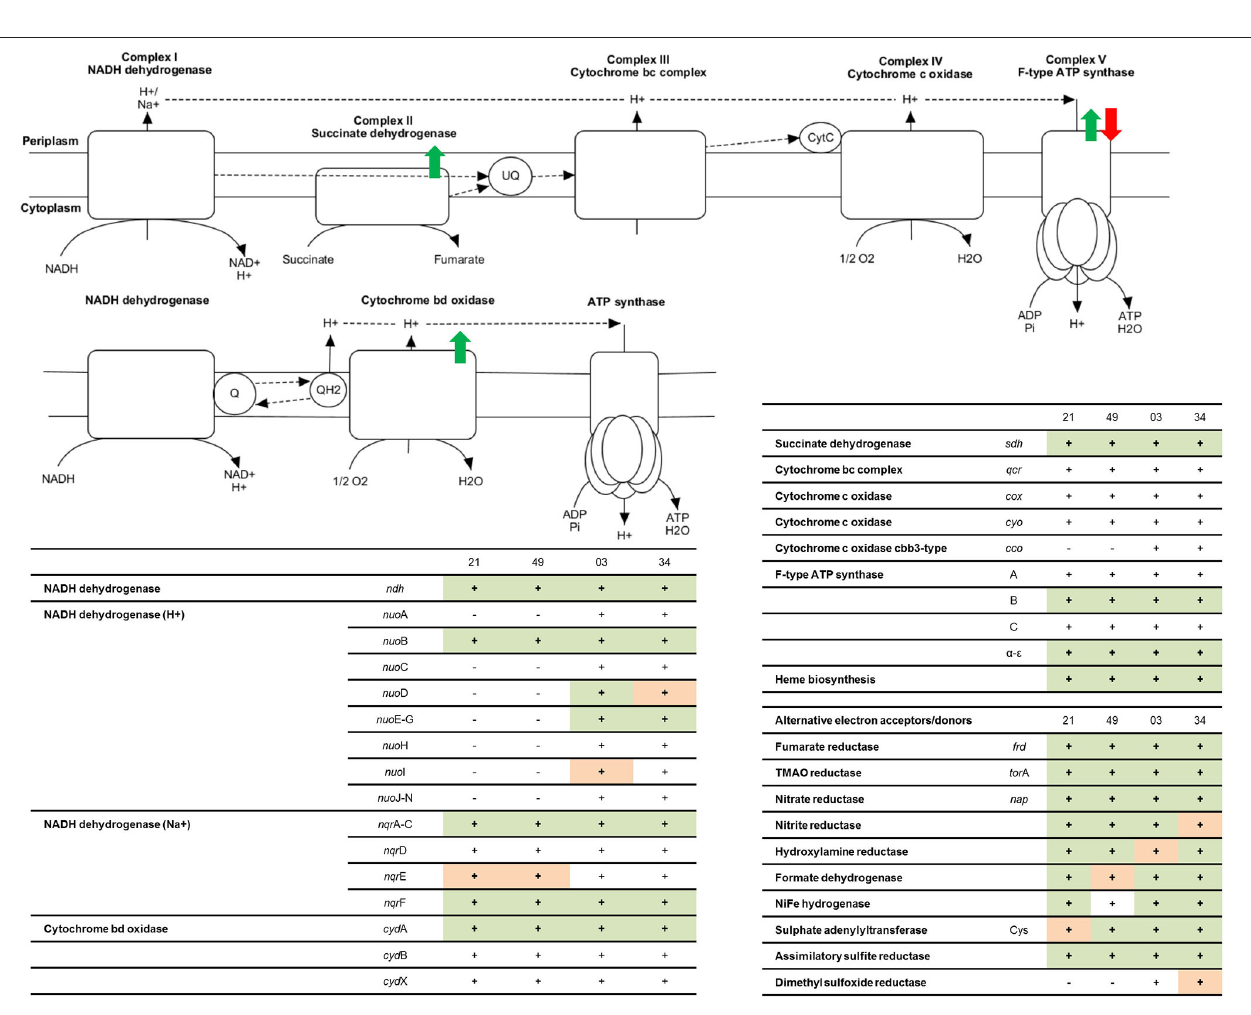
FIGURE 2 | Representation of the functional respiratory chain according to enzymes coded in the genome of photobacteria. Colored arrows represent the regulation points when comparing oxic and anoxic conditions observed: green = higher accumulation under aerobic conditions, compared to anaerobic, red = higher accumulation under anaerobic conditions. The tables include a summary of proteins involved in the respiratory chain for each strain: 21 = P. carnosum TMW 2.2021 T , 49 = P. carnosum TMW 2.2149, 03 = P. phosphoreum TMW 2.2103, 34 = P. phosphoreum TMW 2.2134. − = the gene is not present in the genome of the strain, + (blank) = the gene is present in the genome of the strain but no data for its expression was found in the proteome, + (orange) = the gene is present in the genome of the strain and expression data was found in some of the conditions analyzed, + (green) = the gene is present in the genome of the strain and expression data was found in all conditions